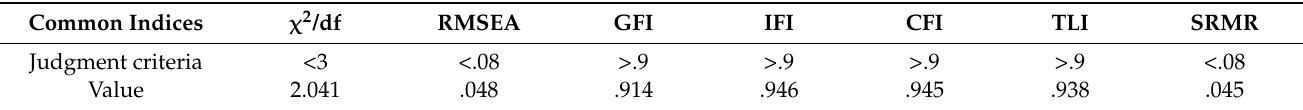
Figure 4. Results of the structural equation model test. Table 9. Structural equation model fit.